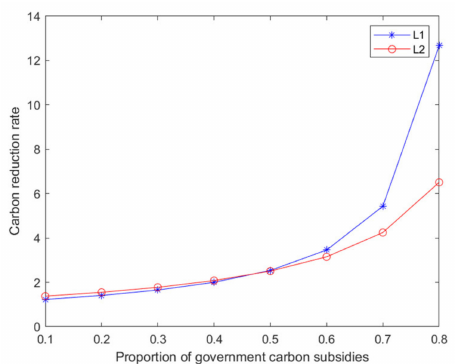
Figure 6. The impact of the carbon emission reduction cost coefficient on electricity price under centralized decision making with government carbon emission reduction